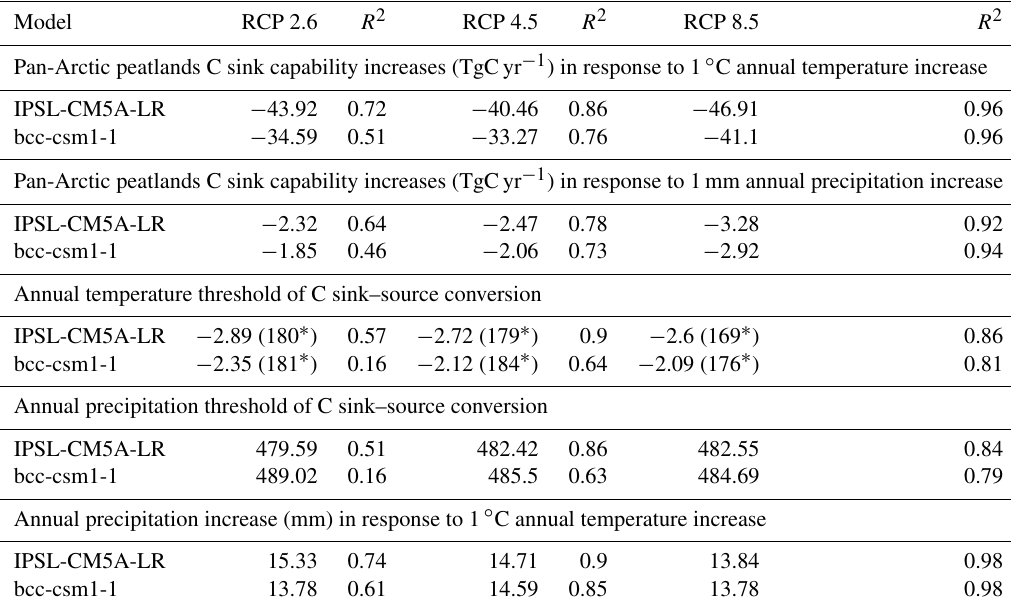
Table 4. Relationship between pan-Arctic temperature, precipitation and C sink. Model RCP